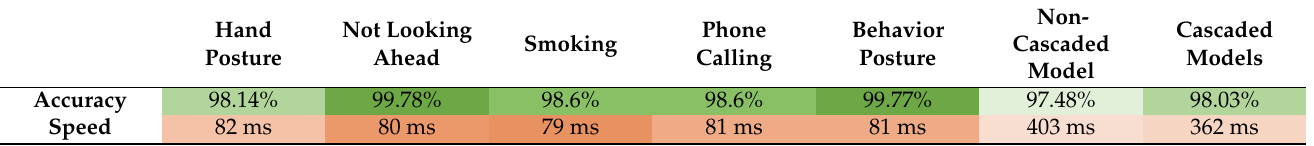
Table 5. Comparison of cascaded models and non-cascaded model for night data